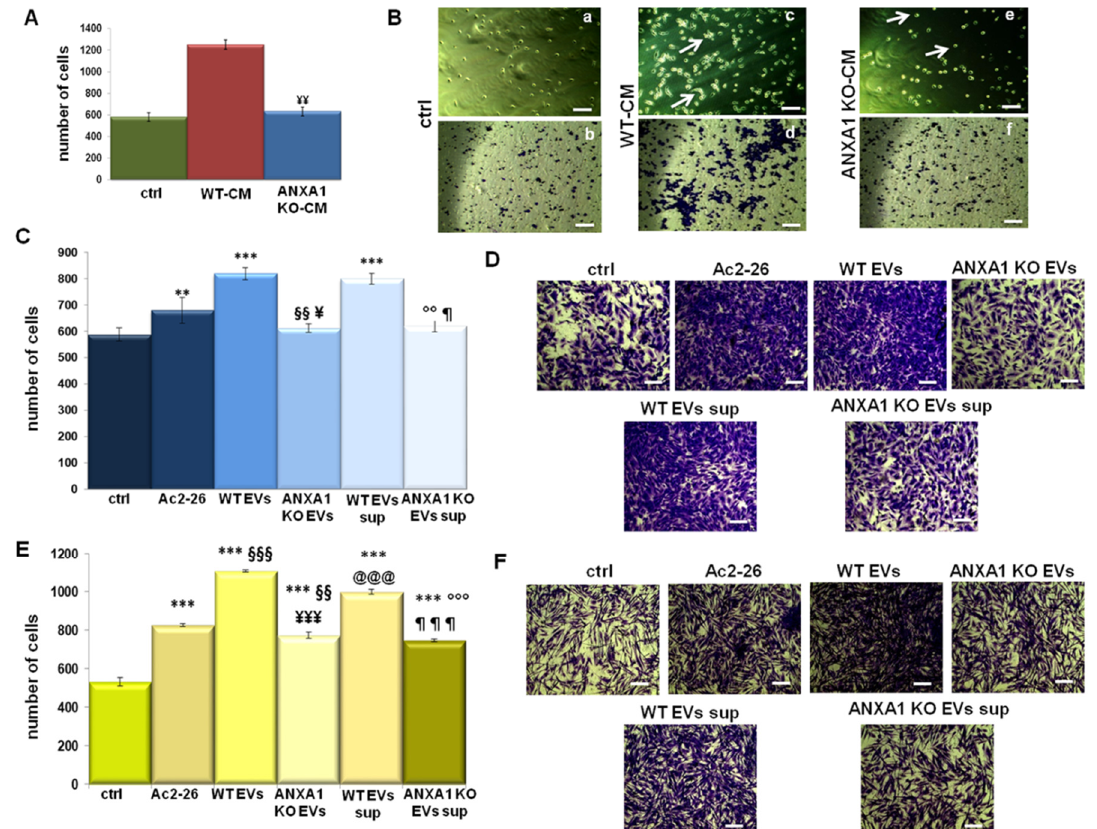
Figure 3. ANXA1 effects on TME. ( A ) Co-culture system performed by THP-1 macrophage invasion assay to WT and ANXA1 KO conditioned medium (CM). ( B ) Bright filed images of THP-1 cells captured in the bottom of the lower chamber of transwell (panels a, c and e) and representative images of macrophages in the same experimental points stained by crystal violet in the matrigel coating in the upper chamber of the generated invasion system (panels b, d and f). Results of ( C ) HUVEC and ( E ) BJ cells invasion to polarized M1 or M2 macrophages pretreated for 24 h with WT and ANXA1 KO MIA PaCa-2 EVs, with Ac2-26 (1 µM) and with the supernatants of THP-1 pretreated for 24 h with WT and ANXA1 KO MIA PaCa-2 EVs. The relative bright field images were shown in ( D ) for HUVEC and in ( F ) for BJ, respectively. Bar = 50 µm. Data represent the mean of four independent experiments ± standard deviation with similar results. ** p < 0.01; *** p < 0.001 for treated cells vs. PMA treated controls; §§ p < 0.01; §§§ p < 0.001 for each point with ANXA1 KO EVs vs. Ac2-26; ¥ p < 0.05; ¥¥ p < 0.01; and ¥¥¥ p < 0.001 for each point with ANXA1 KO EVs vs. WT EVs; ◦◦ p < 0.01; ◦◦◦ p < 0.001 for ANXA1 KO EVs sup. vs. Ac2-26; ¶ p < 0.05; and ¶¶¶ p < 0.001 for ANXA1 KO EVs sup. vs. WT EVs sup; @@@ p < 0.001 for WT EVs sup. vs.